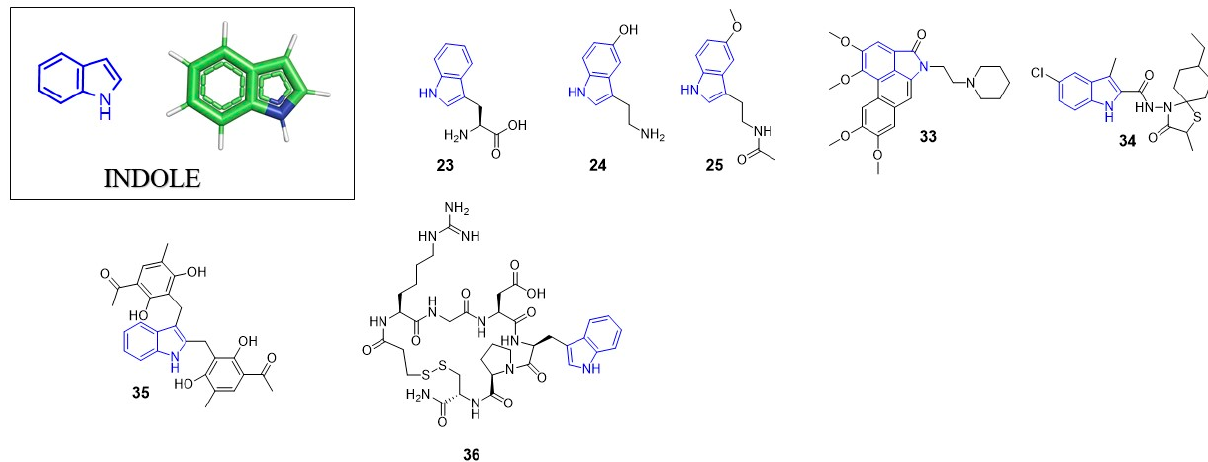
Figure 3. Important compounds ( 23–25 ) and antivirals ( 33–35 ) with indole ring.